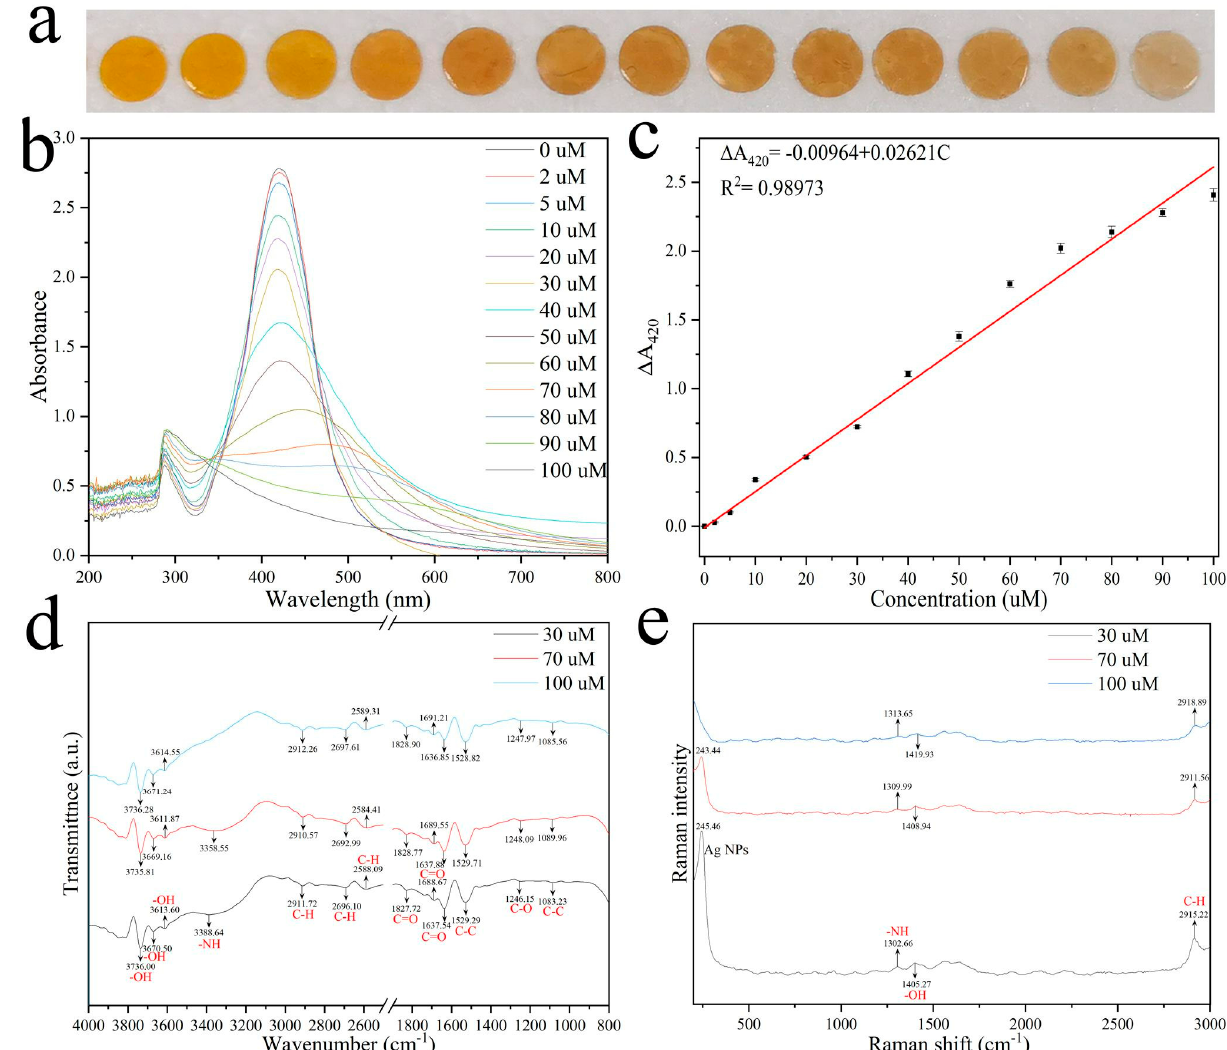
Figure 2. ( a ) Photographs of Ag NP films exposed to histamine at different concentrations. ( b ) UV − vis spectra of Ag NPs films exposed to histamine at different concentrations. ( c ) Relationship between Δ A 420 and histamine concentrations, the error bars represent the standard deviation for five trials ( n = 5); FTIR ( d ) and Raman ( e ) spectra of Ag NP films exposed to histamine at different concentrations.